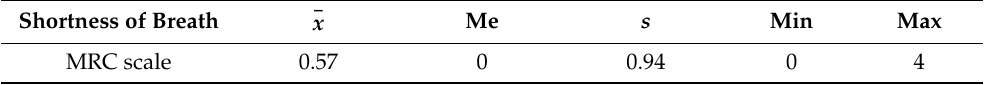
Table 4. Level of dyspnoea in persons infected with the SARS-CoV-2